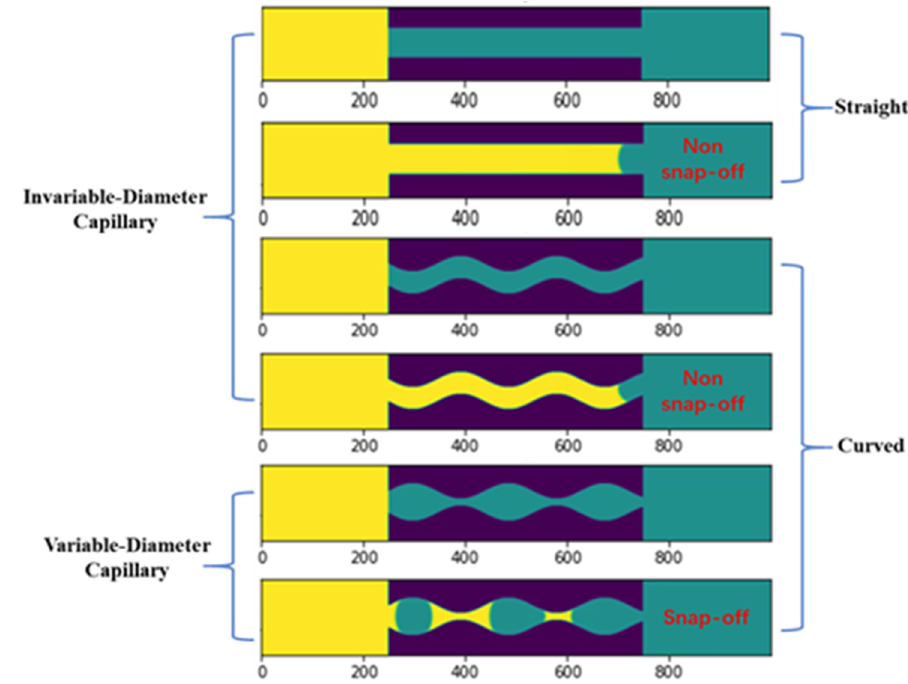
Figure 14. Distribution of snap-off and non-snap-off phenomena during the spontaneous imbibition process.